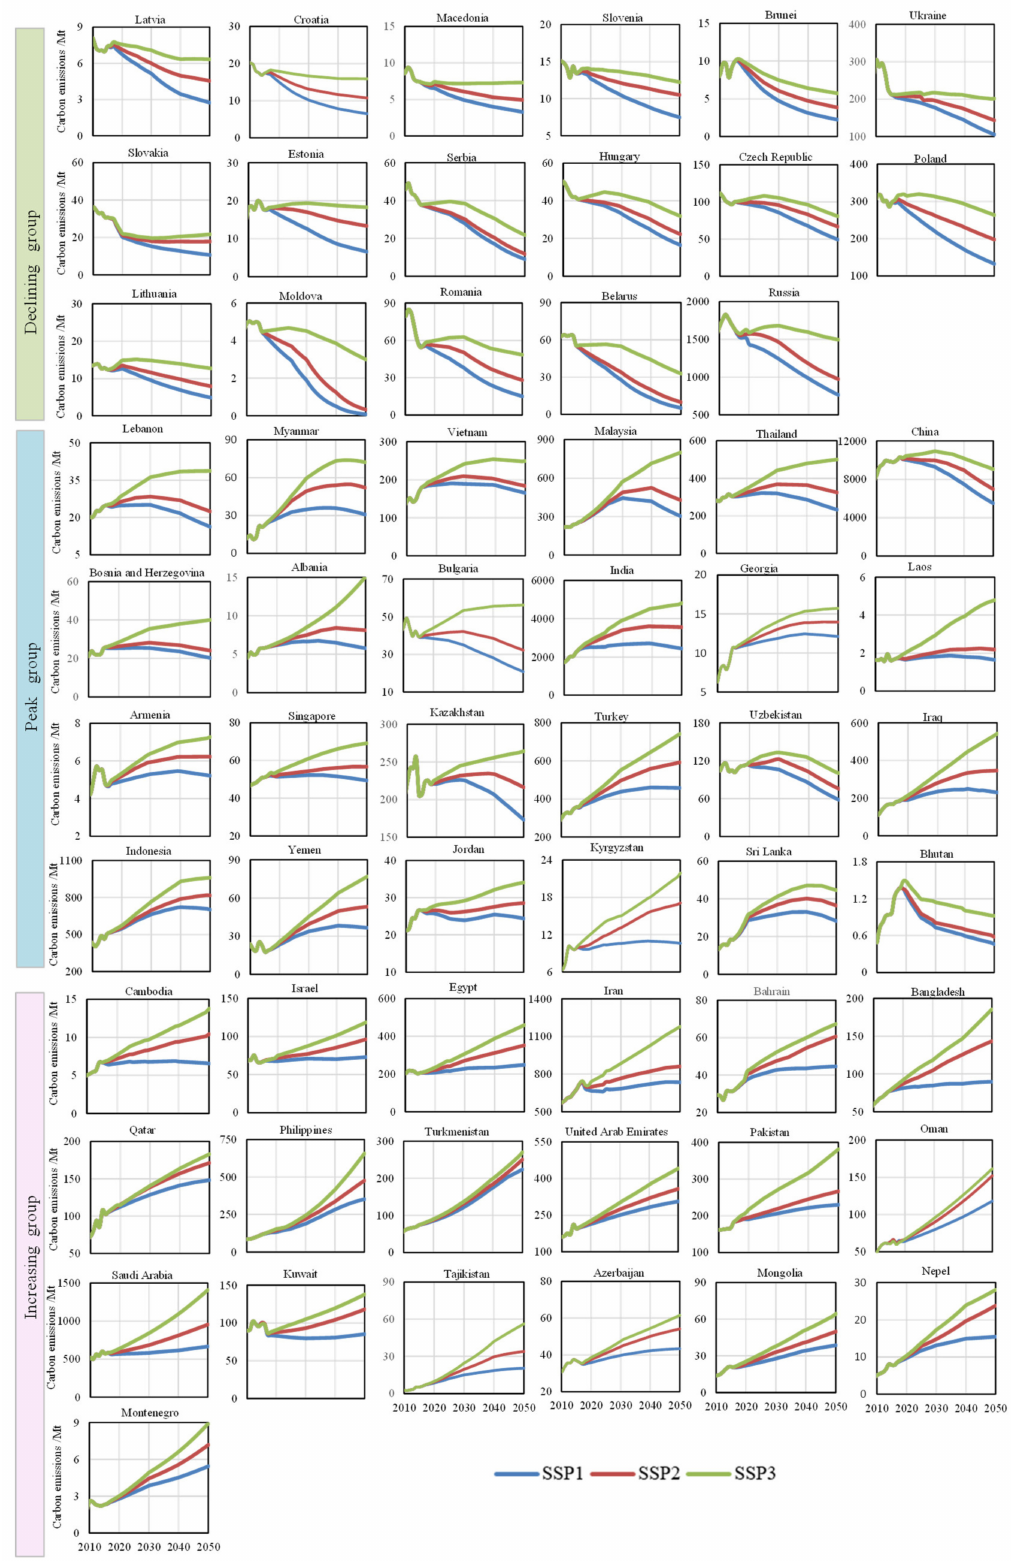
Figure 6. Carbon emissions of 60 B&R countries under different SSPs. Plots are categorized by emission trajectories belonging under SSP1. The green, blue, and pink label on left of picture represent declining group, peak group, and in-creasing group,